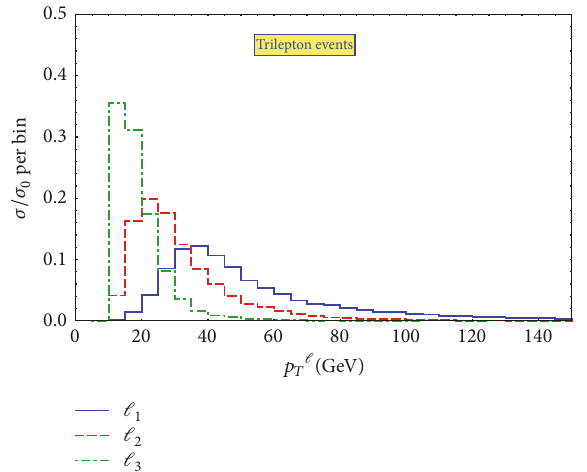
Figure16:Transversemomentumdistributionsofthejets (𝑝 the same-sign dilepton plus di-jet final state.